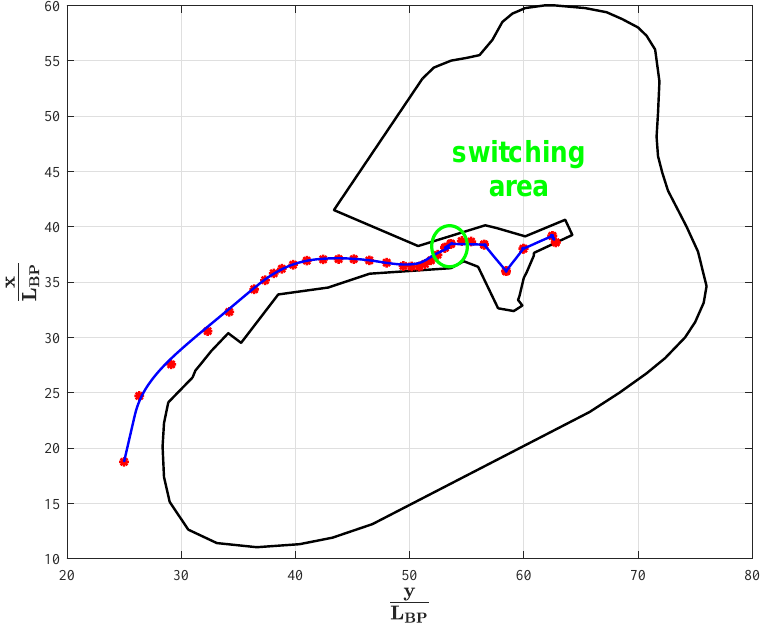
Figure 13. From blue to narrow water: vessel